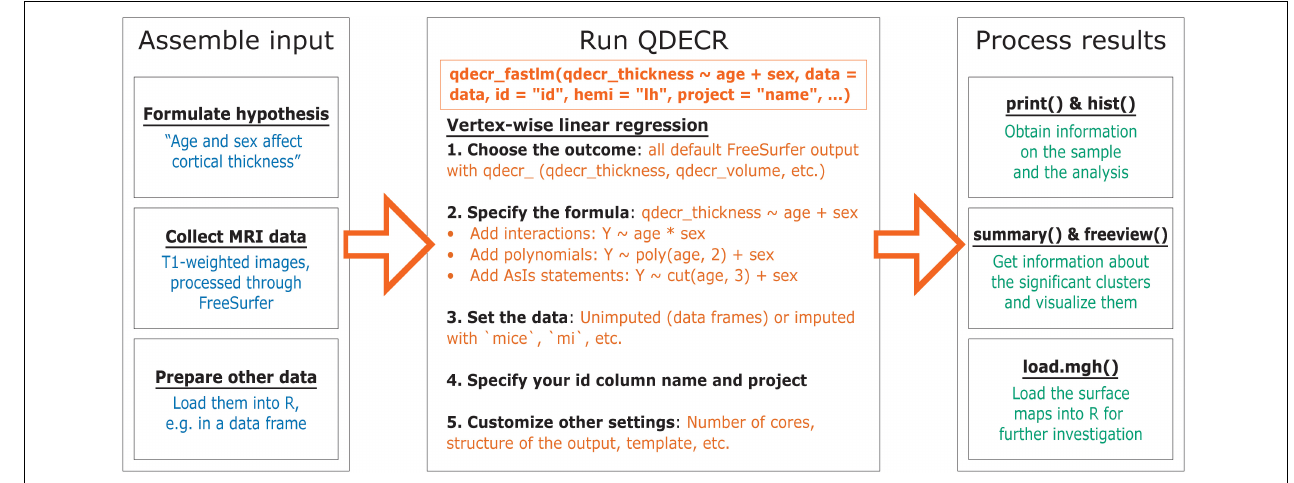
FIGURE 1 | General workflow of the QDECR package, from data collection to